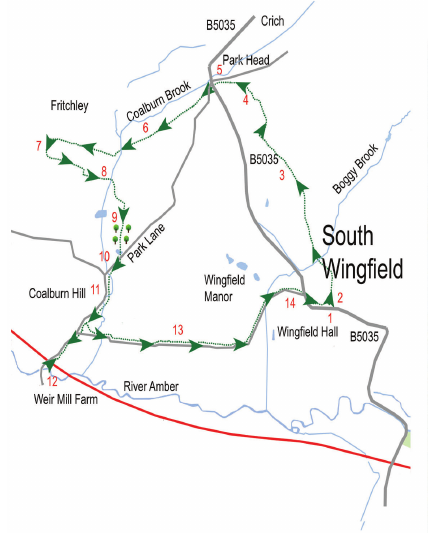
Figure 2. Map of South Wingfield walking route, extracted from flyer number 2 of a series of 18 produced by The Pentrich and South Wingfield Revolution Group. Walk compiled by John Hardwick. © The South Wingfield and Pentrich Revolution Group.